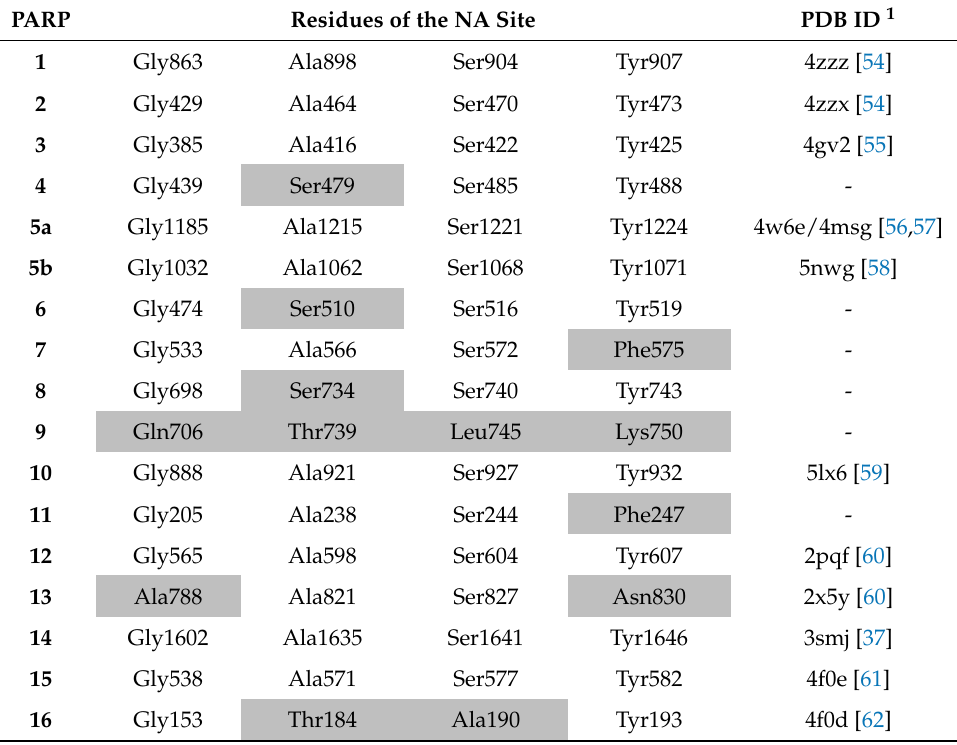
Figure 1. Multiple sequence alignment of PARPs 1–16 with Clustal Omega. The residues 863, 898, 904, and 907 of the NA binding site (PARP-1 numbering) are marked with an asterisk. PARP family members with known structures are marked in green, and PARPs with unknown structures in red. Table 2. Residues of the NA binding site in PARPs 1–16. Amino acid replacements are marked in